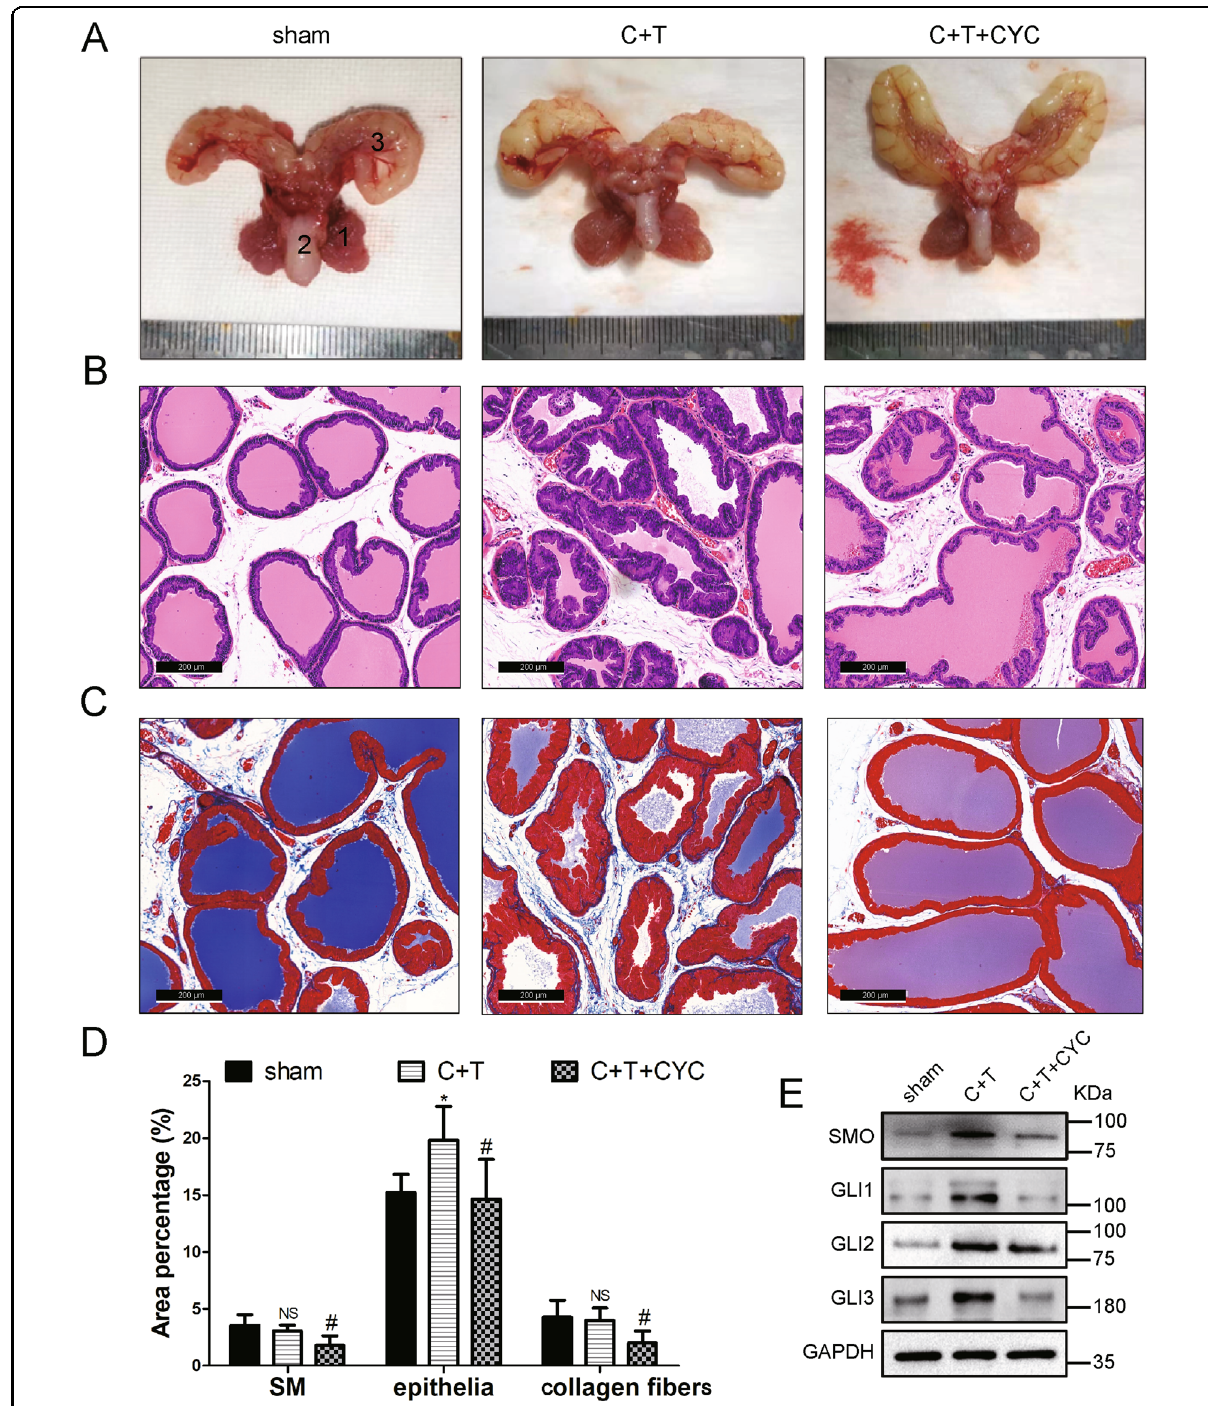
Fig. 6 CYC may suppress BPH via decreasing SMO and GLI family in vivo. A The rat urogenital tissues from sham, BPH, and CYC-treated rats. (1) ventral prostate, (2) seminal vesicle, and (3) bladder. B Representative H&E staining of sham, BPH, and CYC-treated rat prostates. C Masson ’ s trichrome staining of sham, BPH, and CYC-treated rat prostates; prostate epithelial cells were stained orange, SM cells were stained red, and collagen fi bers were stained blue. D Quanti fi cation of Masson ’ s trichrome staining. E Immunoblot assay of SMO and GLI family in sham, BPH, and CYC-treated rats. n = 12 for each group. NS means no signi fi cance, * p < 0.05 BPH vs Control, # p < 0.05 CYC vs BPH; one-way ANOVA. The scale bars are 200 μ